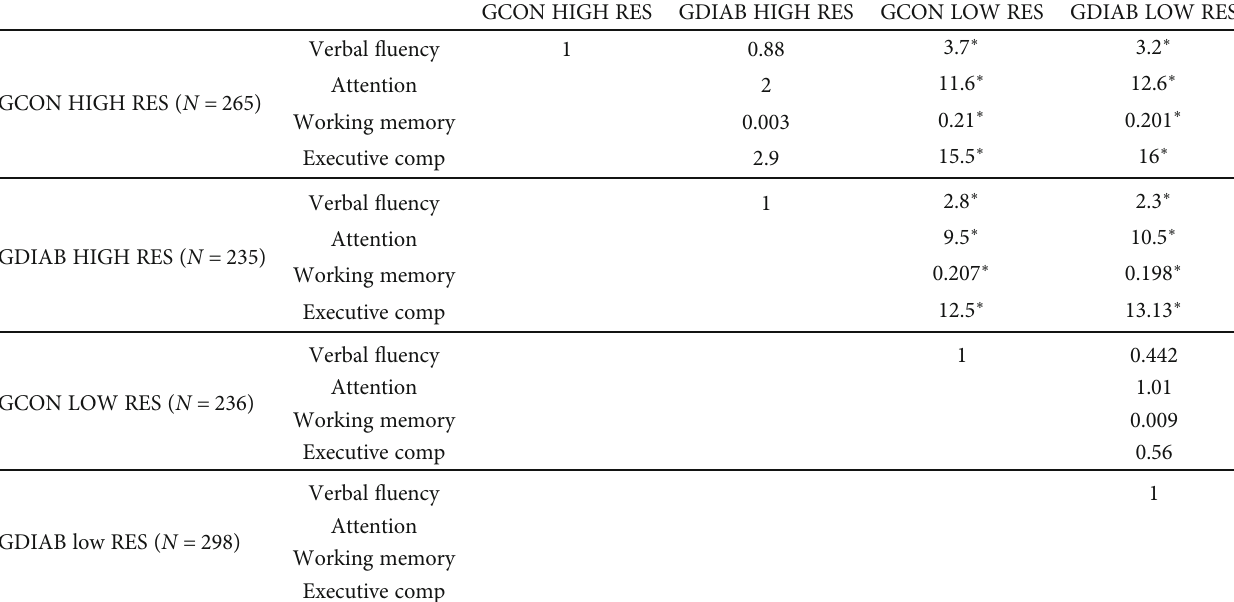
Table 3: Post hoc comparisons using Tukey ’ s HSD. Mean di ff erences shown.